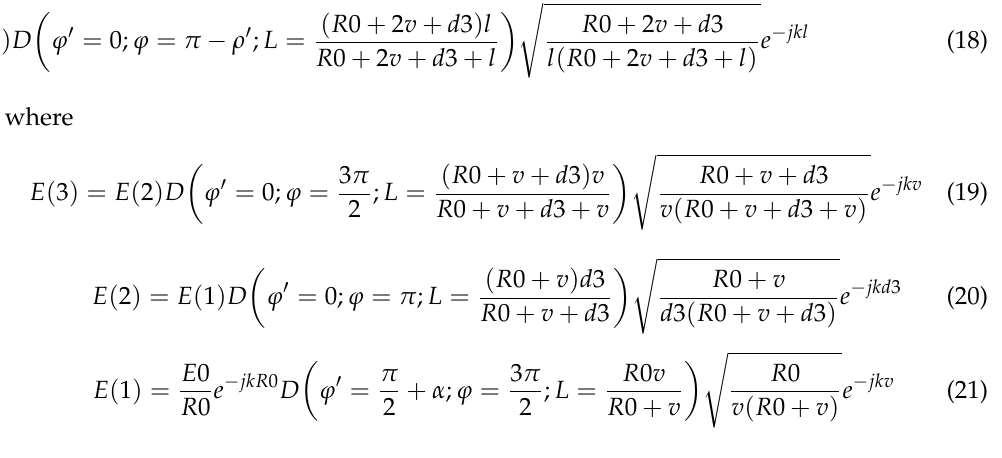
Figure 11. Second triple diffraction (Edif_t2) of the considered LOS scenario.